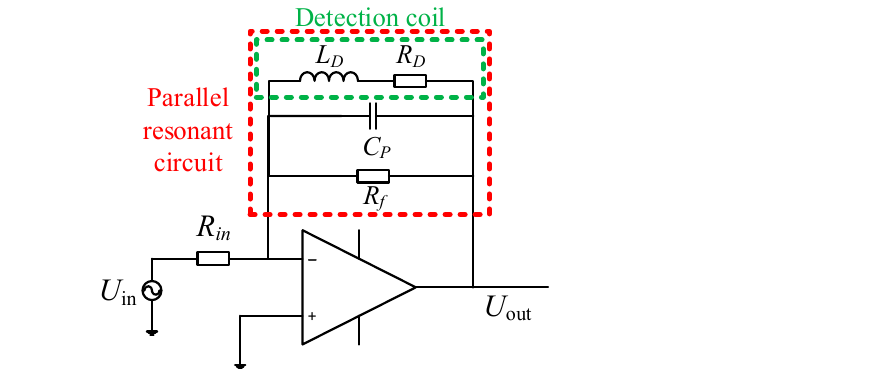
Figure 4. Impedance amplification detection circuit of detection coil based on parallel resonance. Due to the detection coil impedance variation affected by the foreign metal object’s existence, the parallel resonant topology will deviate from the resonance state. As a result, the whole impedance of parallel resonant topology and the amplification ratio of the output signal of the amplifier circuit will change accordingly. The amplitude change of U out can be directly utilized to judge whether foreign metal objects